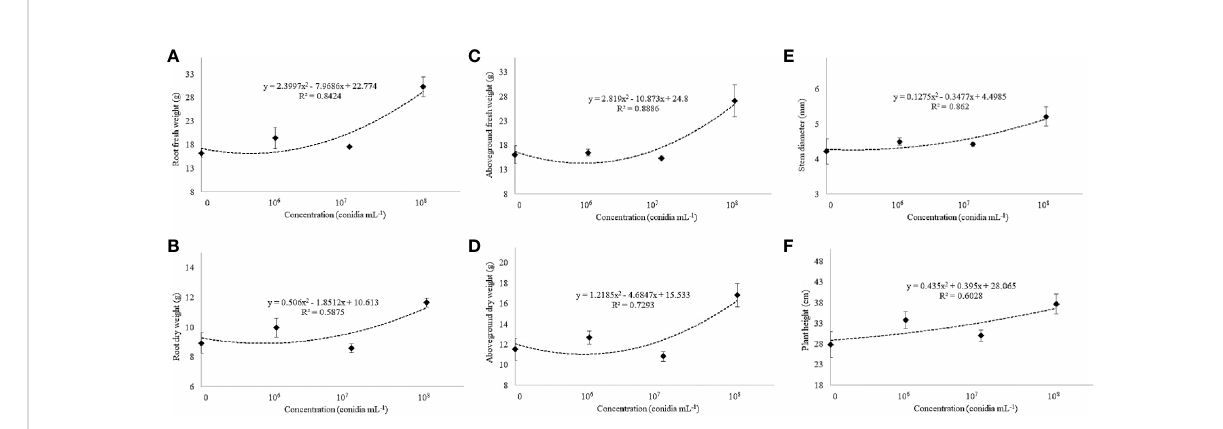
FIGURE 5 Fresh and dry weight of the root (A, B) and aboveground (C, D) , stem diameter (E) , and plant height (F) of cotton cultivar FM 975 WS ® with Trichoderma lentiforme CMAA 1585. Black diamond symbol represents means (± standard error) and the dashed line represents the fi tted quadratic